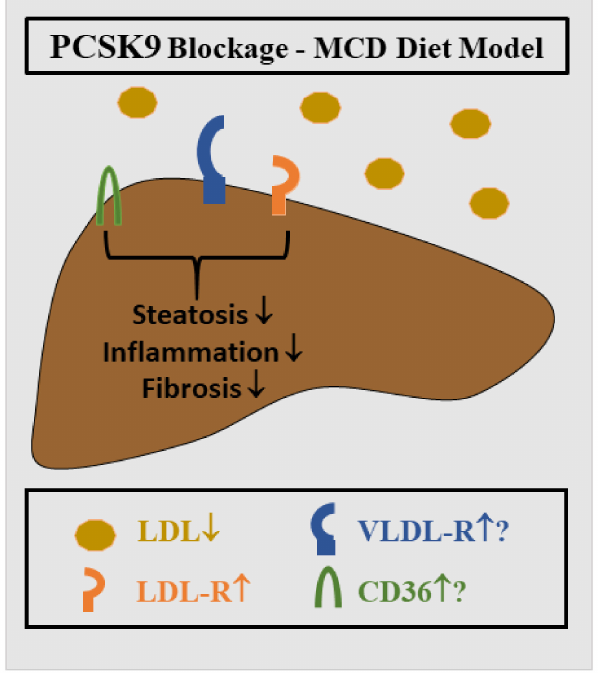
Figure 3. Role of PCSK9 in MCD diet-induced NASH. PCSK9 blockage in mice is associated with low circulating LDL levels and higher LDL-R protein. VLDL-R and CD36 expression in the liver may be also induced. Liver steatosis, inflammation and fibrosis all improved [144].